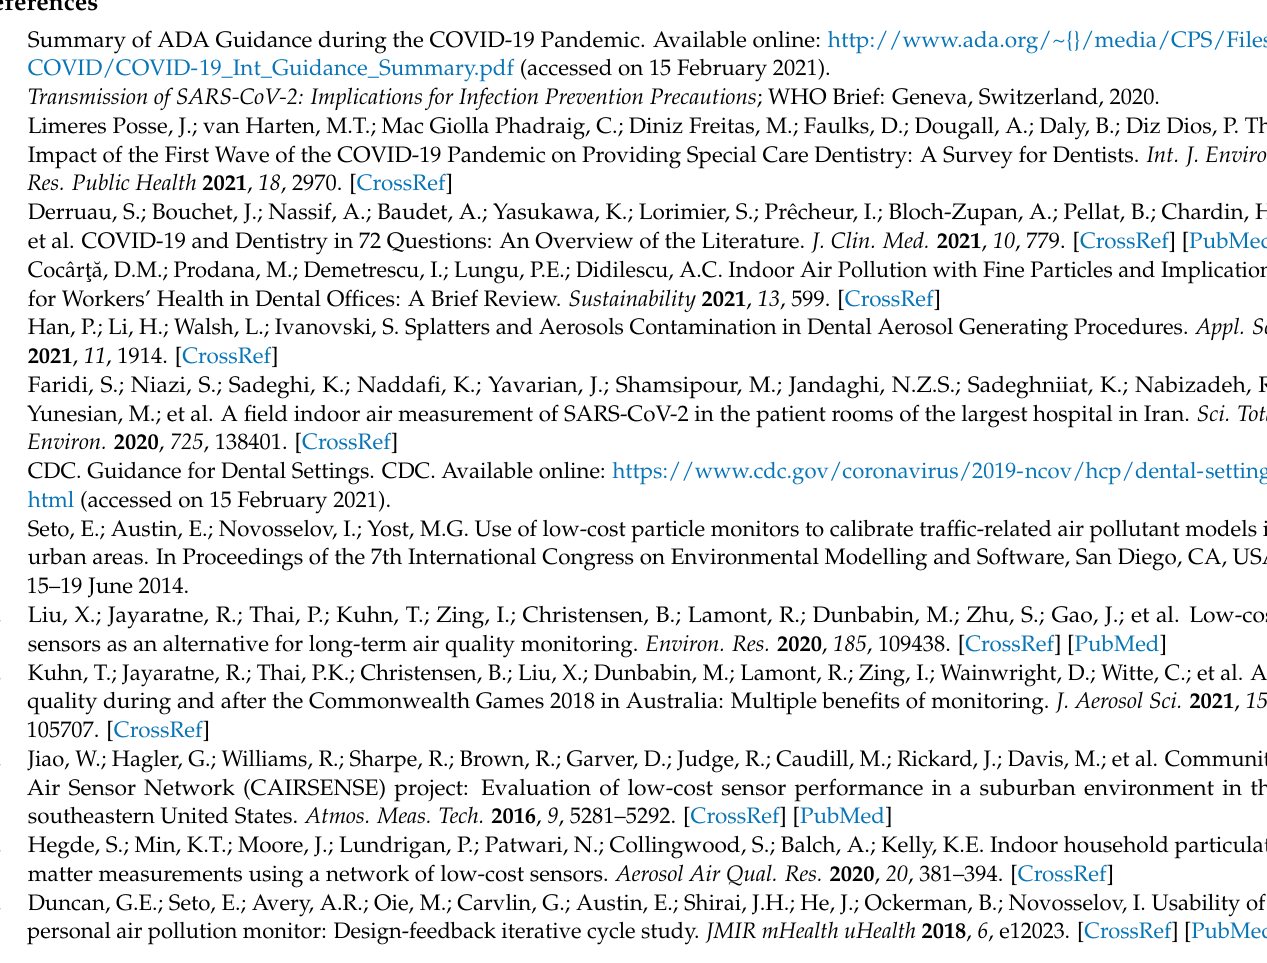
Figure 10’s video: “SoD Restoration